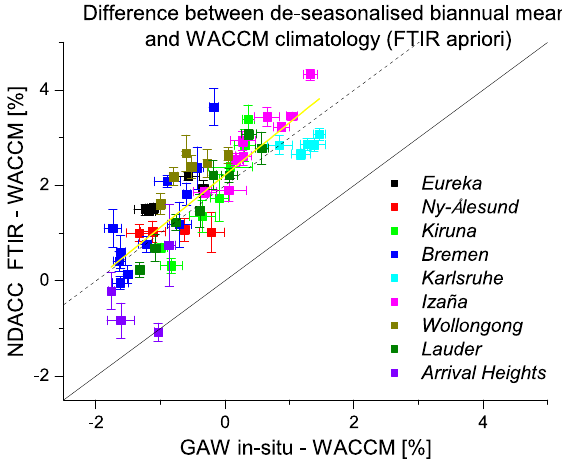
Figure 14. Network consistency between GAW and NDACC FTIR. Plotted are the difference between the deseasonalised biannual mean data and the WACCM climatology (FTIR a priori) for GAW and NDACC FTIR at the nine stations. The solid and dashed black lines indicate the 1 : 1 diagonal, the dashed line being +2% off. The solid yellow line shows the regression